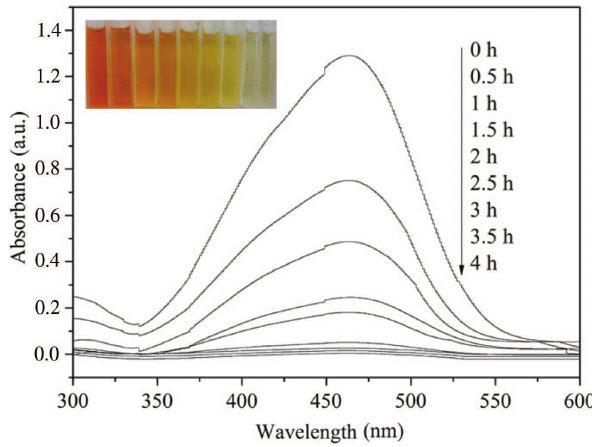
Figure 8: UV-vis spectra of using Cu 2 O/ZnO (sample II) photo- degrade MO with the degradation time.